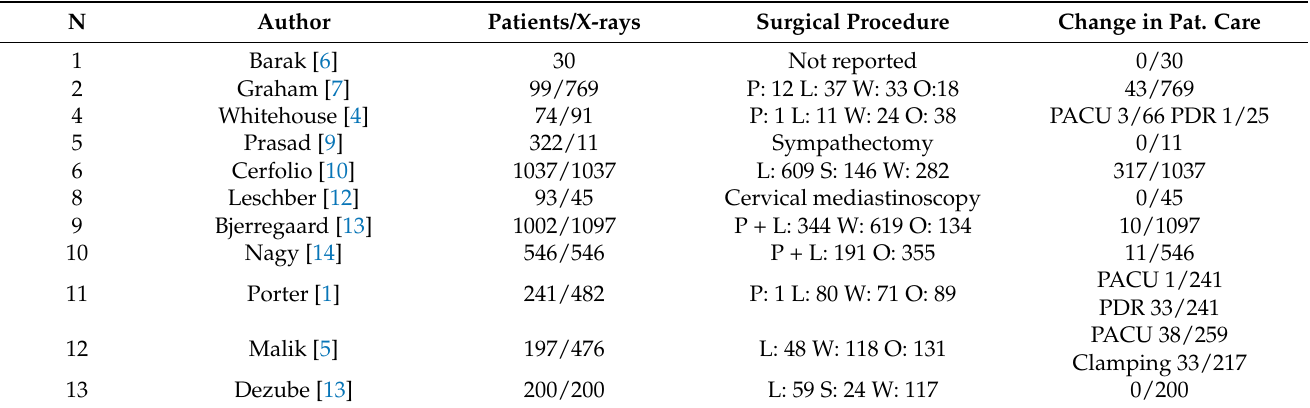
Table 2. Surgical procedures and change in patient